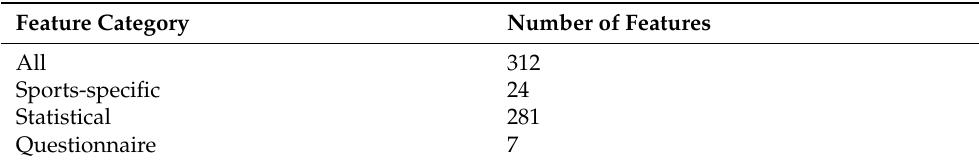
Table 1. Number of features per